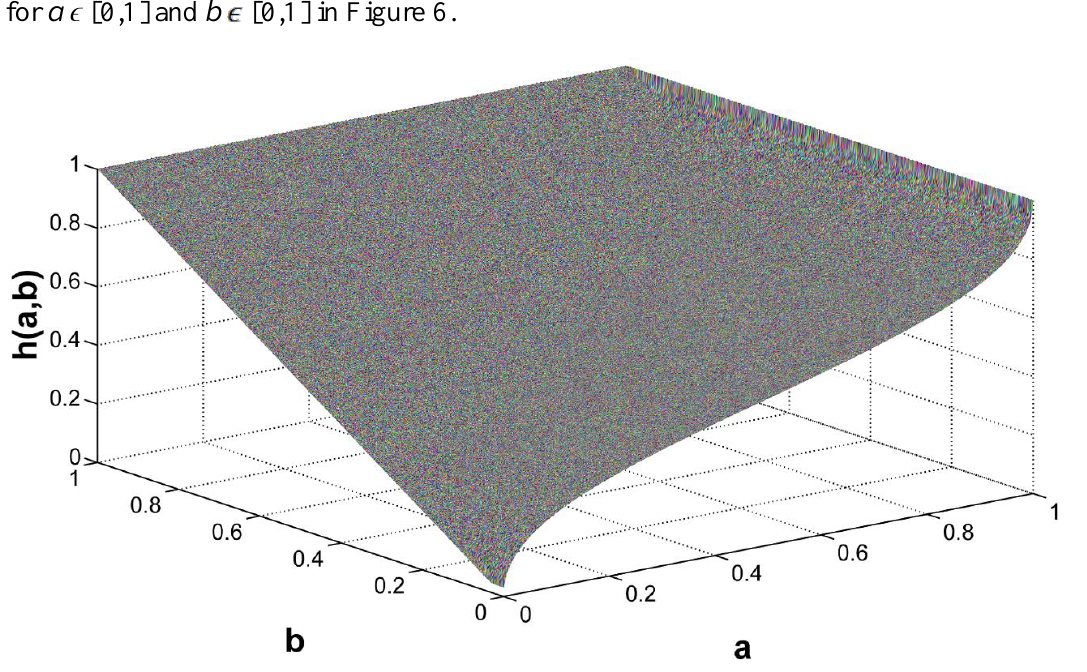
Figure 6. Graph of operator (15) for a ϵ [0,1] and b ϵ